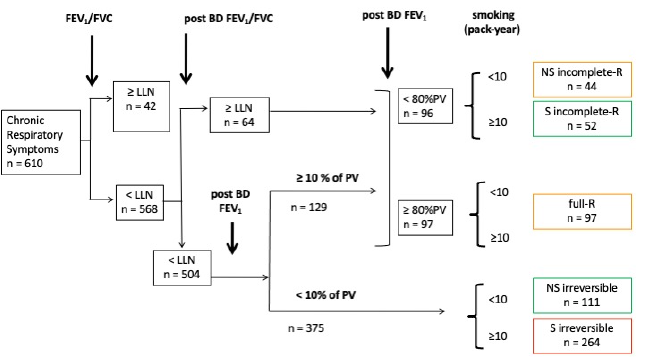
Figure A1. Definition and prevalence of 5 phenotypes of obstructive airway diseases based on bronchial reversibility defined as a >10% change of FEV1 predicted value. FEV 1 : forced expiratory vol- ume in 1 s; FVC: forced vital capacity. BD: bronchodilator; COPD: chronic obstructive pulmonary disease. NS: Non-Smoker. S: Smoker. PV: Predicted Value. -R: Responder.